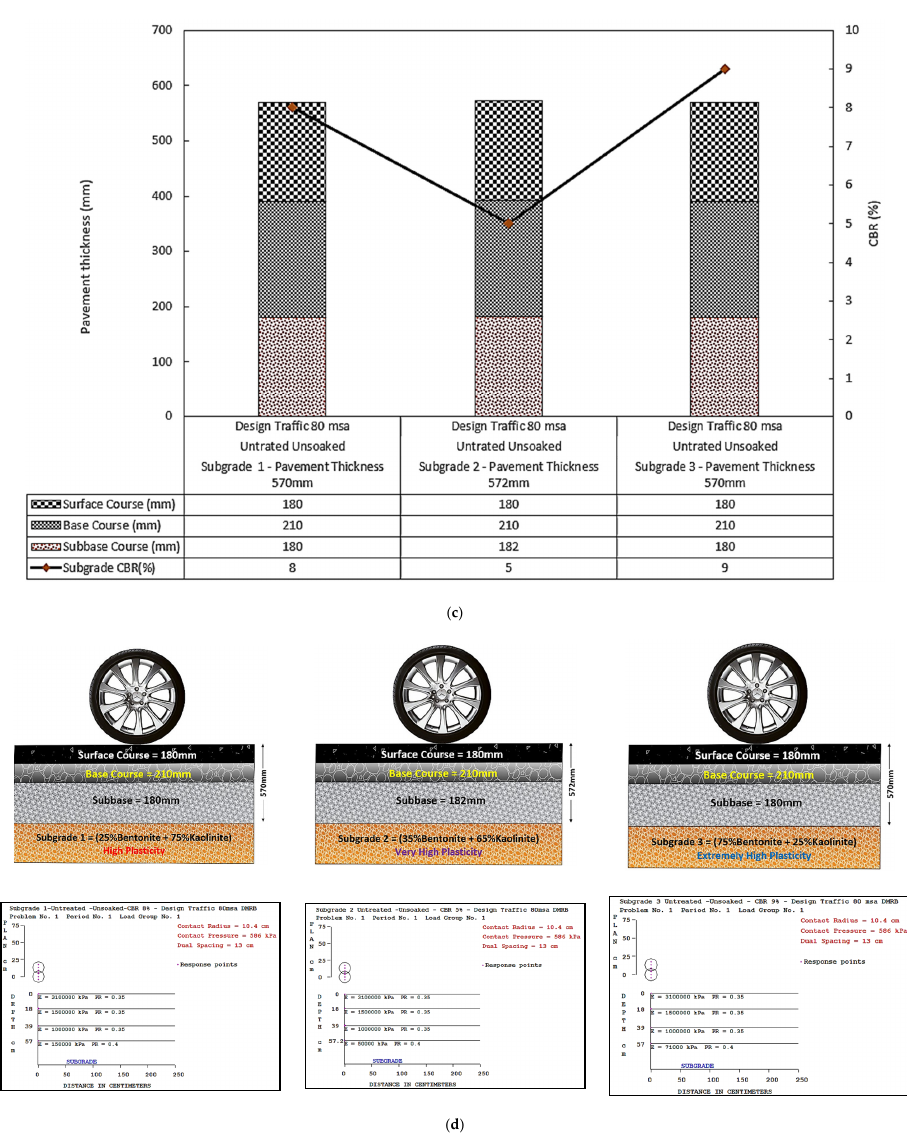
Figure 8. ( a ) Results for DMRB pavement design traffic 8 msa for untreated subgrade; ( b ) pavement thickness and three-layered flexible pavement system from KENPAVE for ASS 1, 2 and 3; ( c ) results for DMRB pavement design traffic 80 msa for untreated subgrade; ( d ) pavement thickness and three-layered flexible pavement system from KENPAVE for ASS 1, 2 and 3.